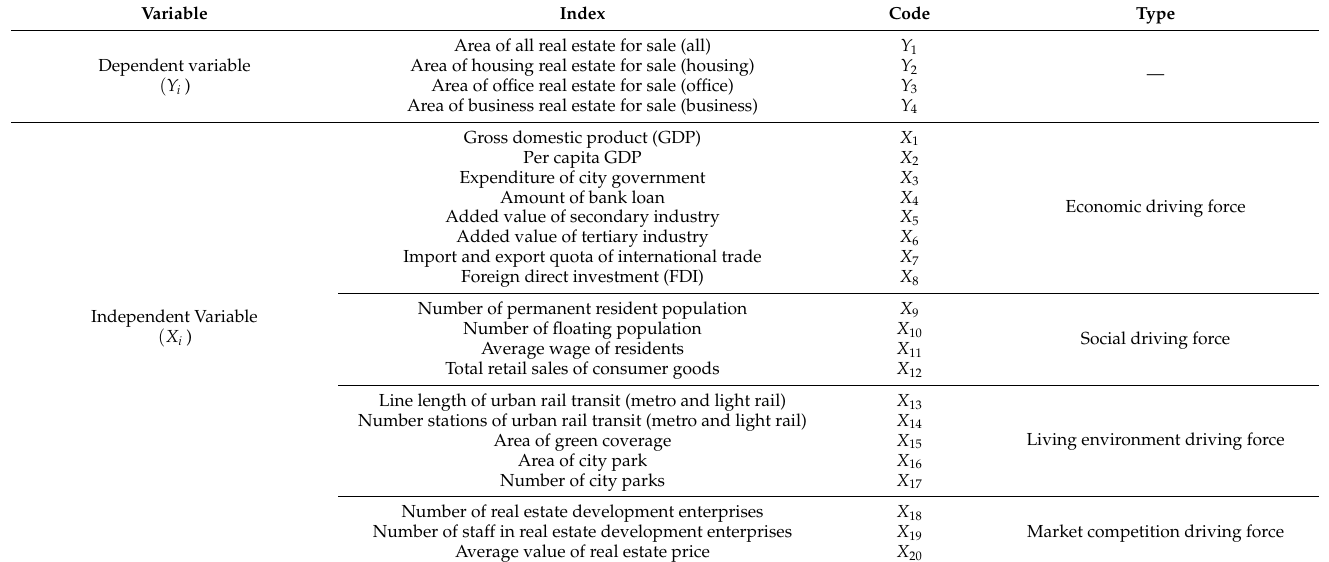
Table 3. Model variable